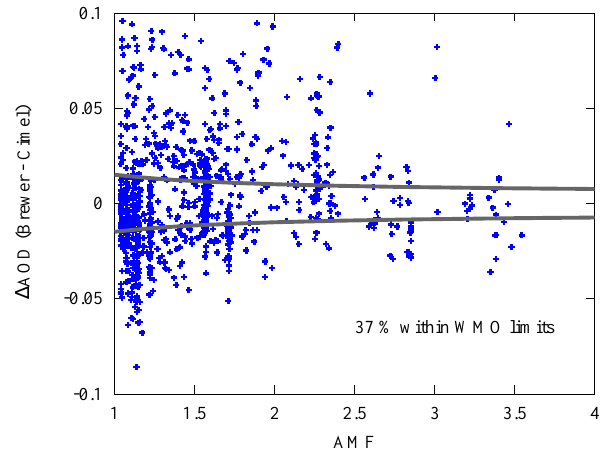
Figure 8. Differences of AODs measured at 437nm by both instru- ments in the period 2008–2014 as a function of the air mass and acceptance limits fixed by WMO